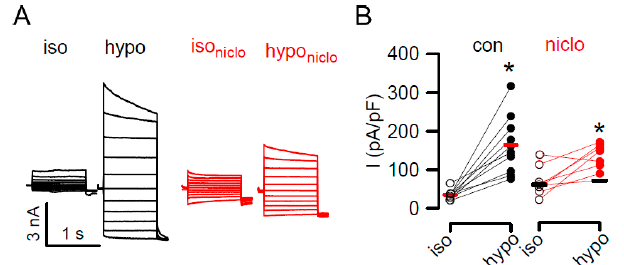
Figure 7. Activation of VRAC is inhibited by niclosamide . ( A , B ) Whole cell patch clamp currents activated by hypotonic cell swelling (hypo; 33% hypotonicity) in Jurkat T lymphocytes, and inhibition of VRAC activation by niclosamide (niclo; 1 µM). Summary of single experiments and mean ± SEM indicating significant inhibition of VRAC by niclosamide ( p < 0.05, unpaired t -test). * significant activation by ( p < 0.05, paired t